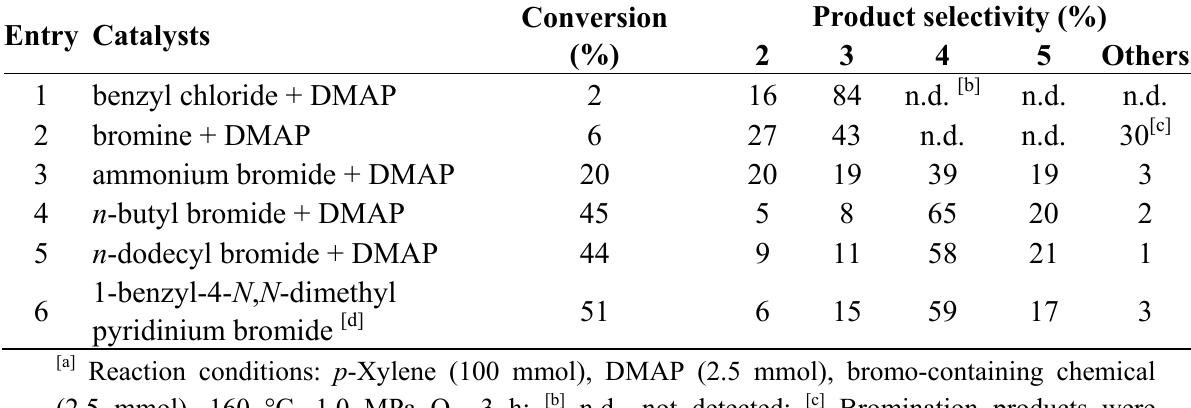
Table 4. Comparison of different bromide sources for p -xylene oxidation [a] .